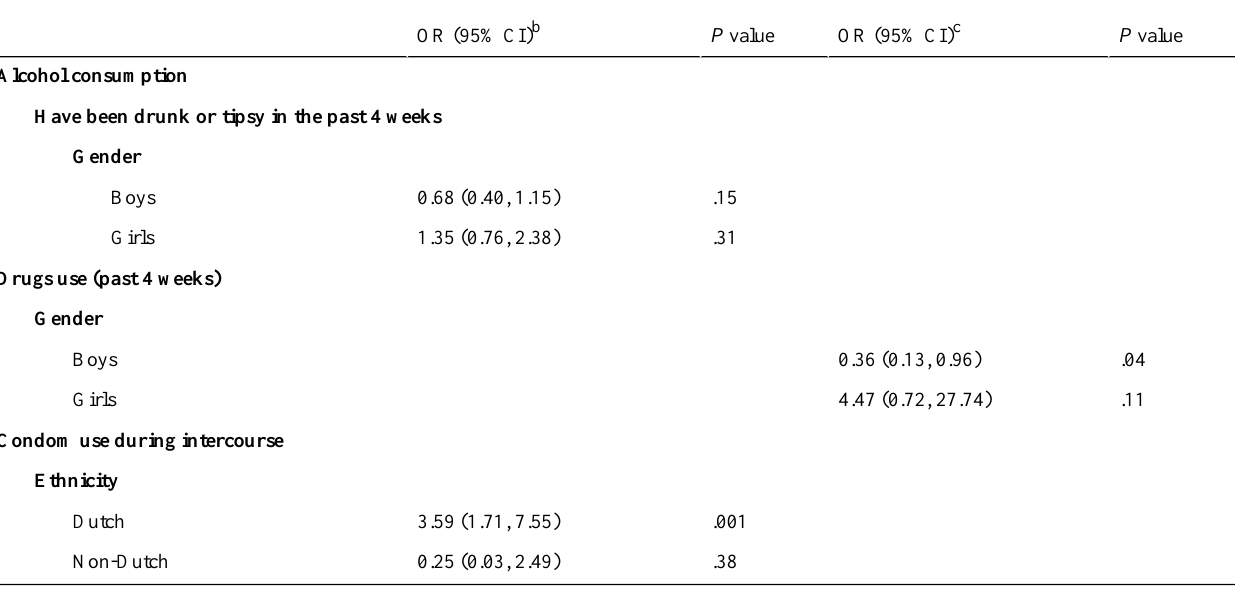
E-health4Uth +consult vs control groupE-health4Uth vs control